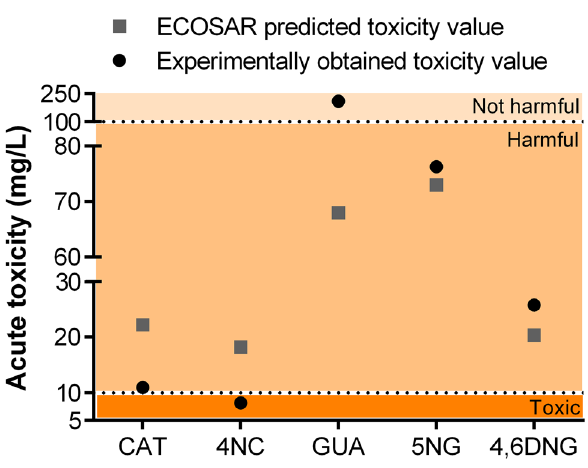
Figure 2. Graphical view of ECOSAR predicted and experimentally obtained toxicity values within the toxicity gradient according to the criteria set by the European Union 34 (Very toxic < 1 mg/L, Toxic 1 < LC 50 < 10 mg/L, Harmful 10 < LC 50 < 100 mg/L, Not harmful LC 50 > 100 mg/L). Predicted values were obtained from ECOSAR v2.0 software (https ://www.epa.gov/tsca-scree ning-tools /ecolo gical -struc ture-activ ity-relat ionsh ips-ecosa r-predi ctive -model ), while GraphPad Prism software version 6.0 (https ://graph pad-prism .softw are.infor mer.com/6.0/) was used for data